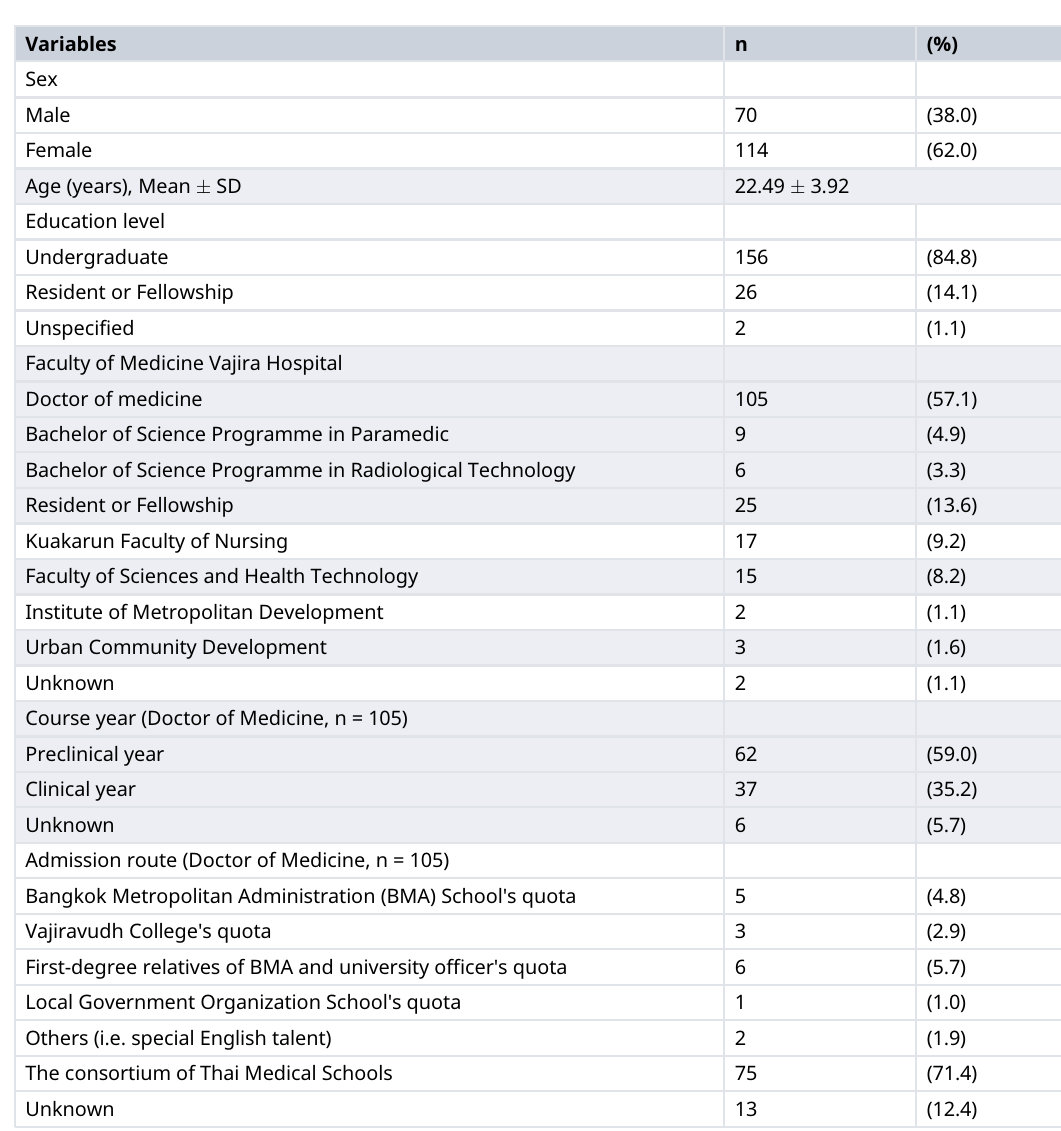
Table 1. Demographic data